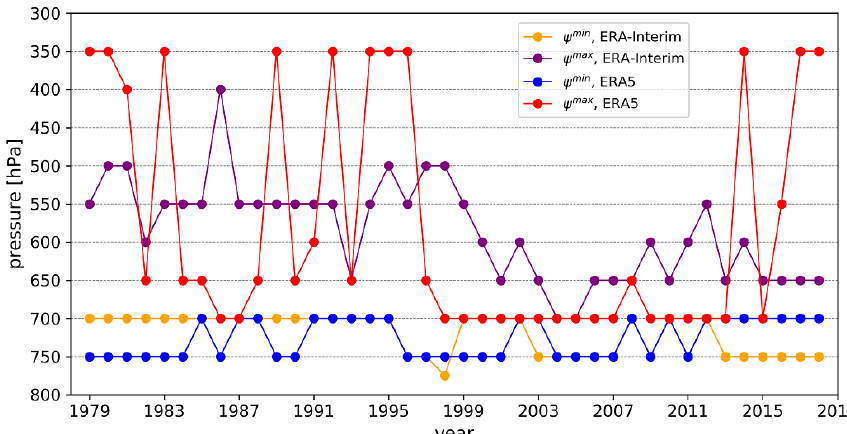
Figure A7. Level of maximum and minimum stream function in annual-mean Hadley circulation between 1979 and 2018 in ERA5 and ERA-Interim